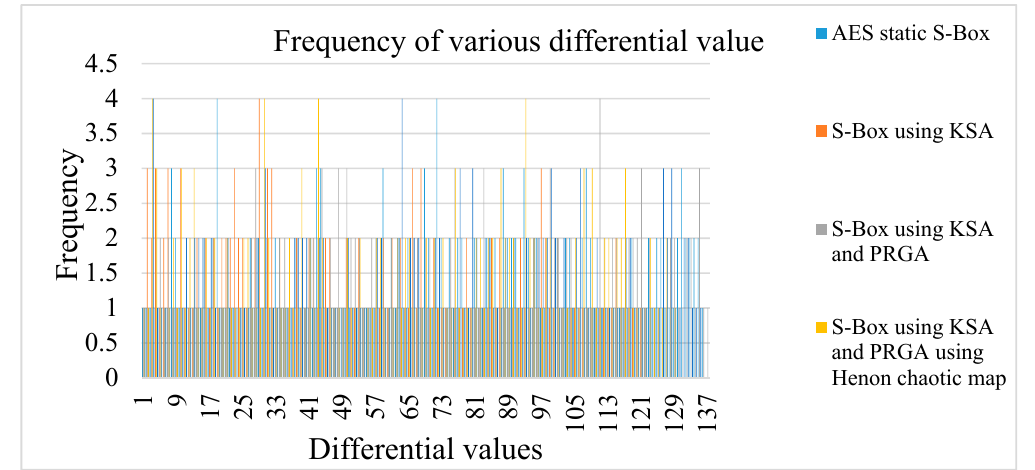
Figure 12. Analysis of the frequency of various differential values ∆ Y for the five S-Boxes with the key “F9E8D7C6B5A40123” .